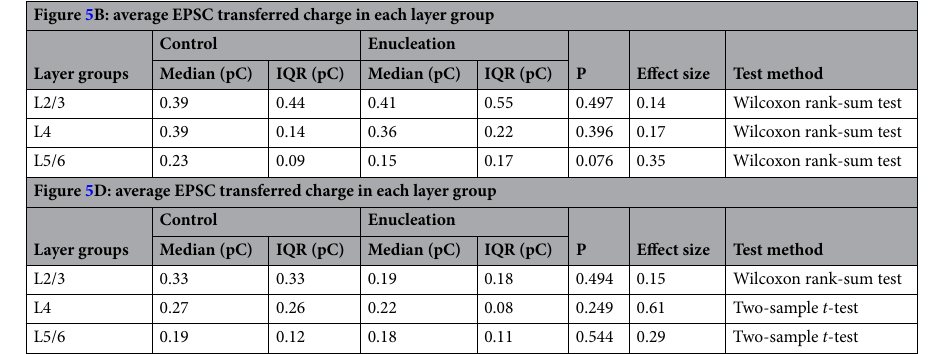
Table 5. Statistics in Fig. 5. IQR interquartile range.